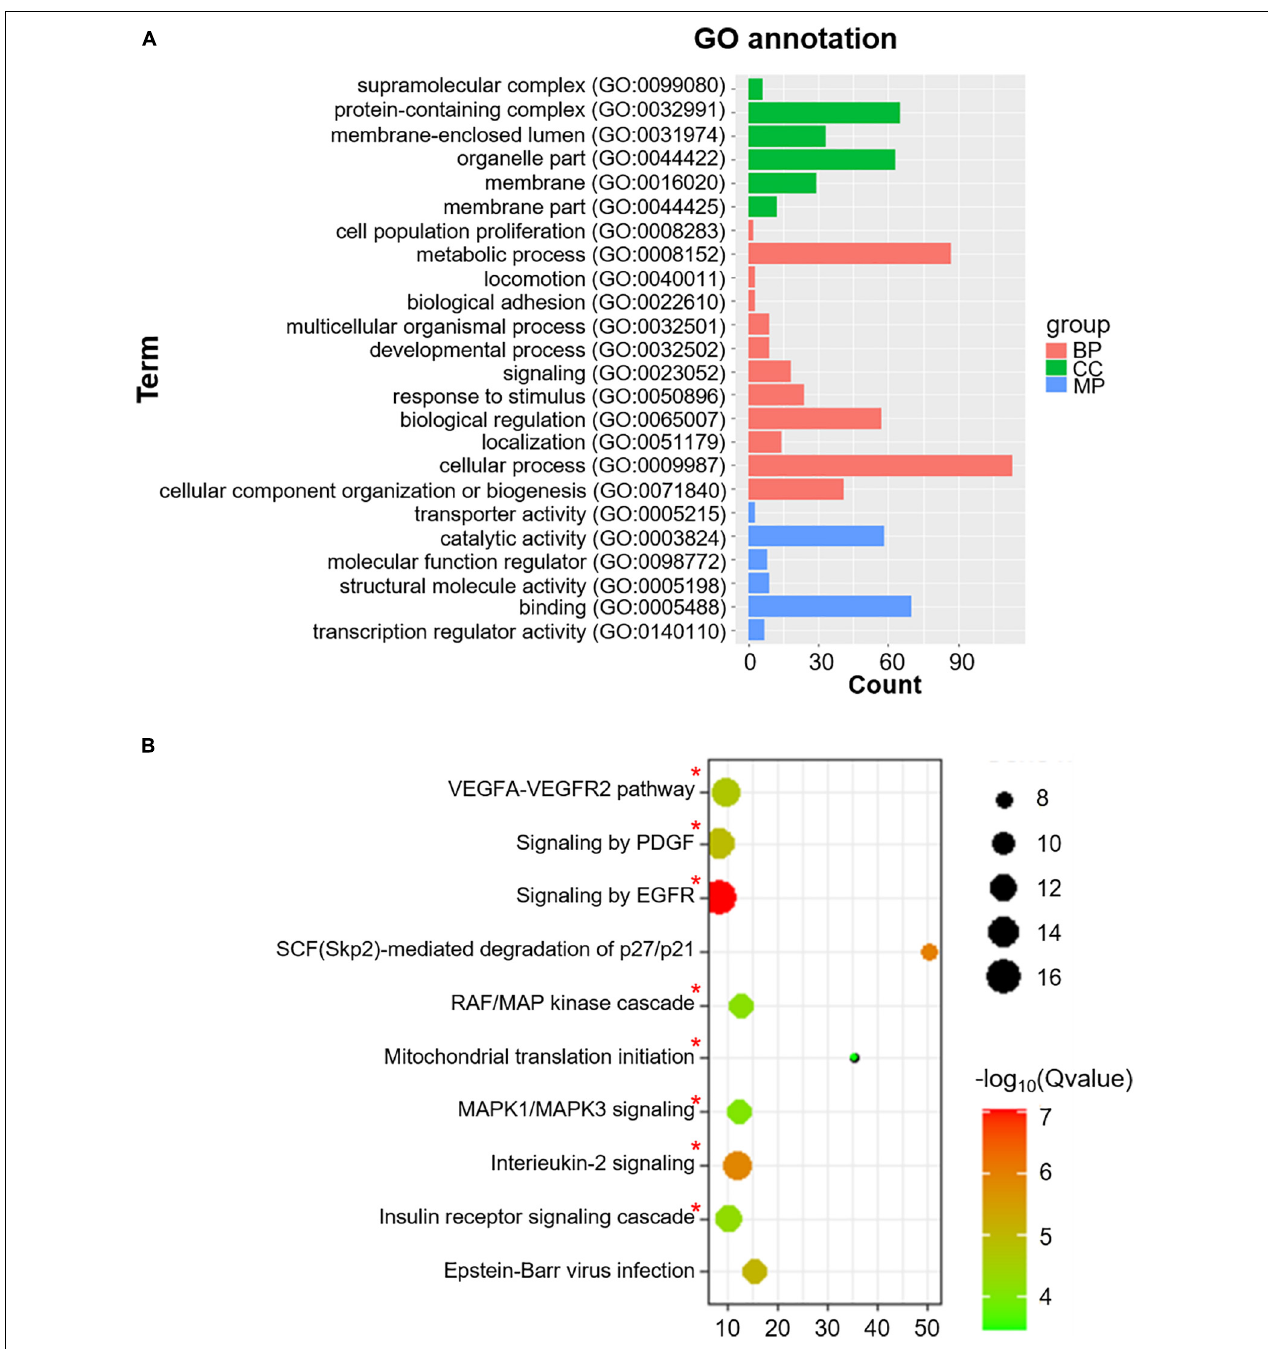
FIGURE 4 | GO functional classification and pathway enrichment analysis of Co-m 6 AR with m 6 A methylation in β -cells. (A) GO functional classification. GO analyses of Co-m 6 AR genes in control versus T2DM islet β -cells. (B) KEGG pathway enrichment. KEGG analyses of Co-m 6 AR genes in control versus T2DM islet β -cells, and the enrichment pathway involved in T2DM development was marked with red